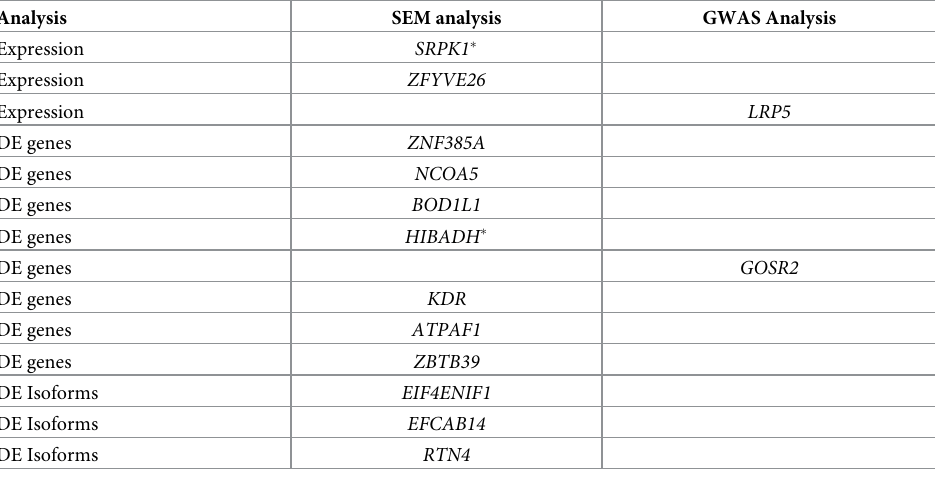
Table 3. Genes uncovered by the expression association and DE analysis, and associated with meat quality.